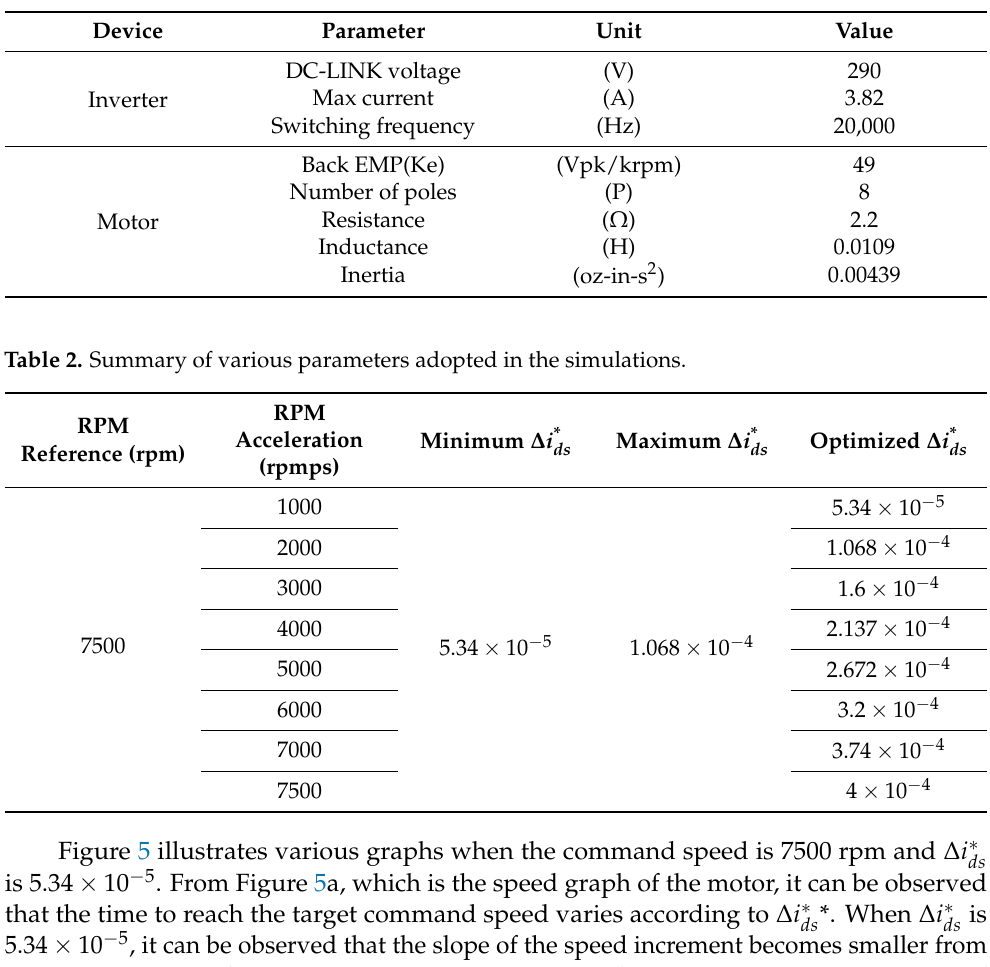
Table 1. Summary of various parameters used in the simulations.